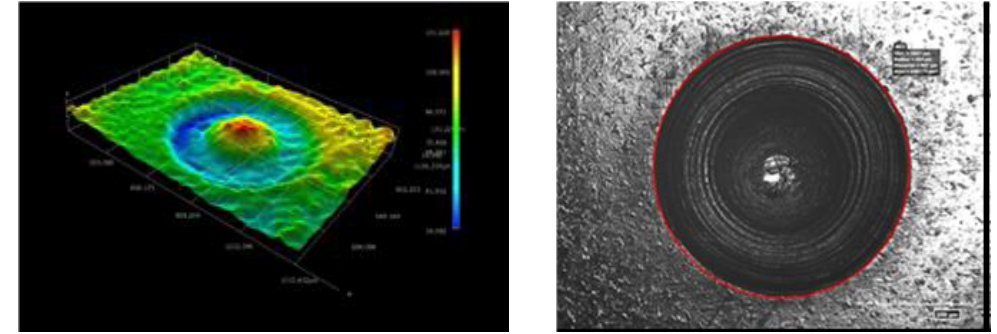
Figure 2: The geometric profile of the test weld face constituting an image of the Nd – YAG BLS 720 laser beam: stereoscopic view on the left, x200 magnification on the right.